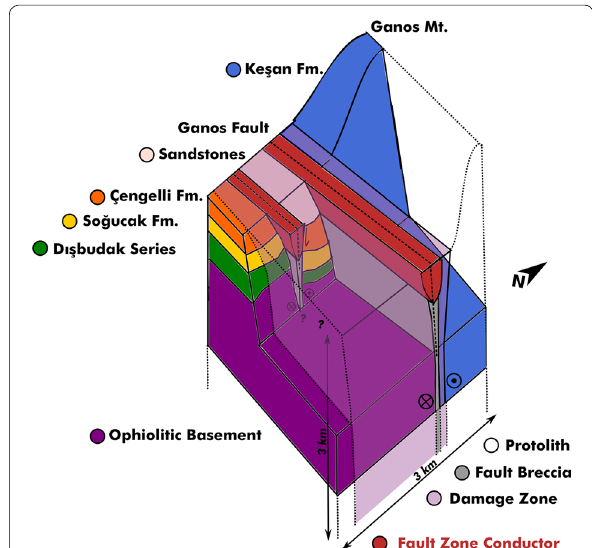
Fig. 8 Conceptual sketch of geological interpretations of the results of the magnetotelluric study. A fluid-bearing asymmetric damage zone representative of resistivity models is drawn around the Ganos Fault. The potential flower structure formed by the main strand and the oblique subsidiary fault in the south are